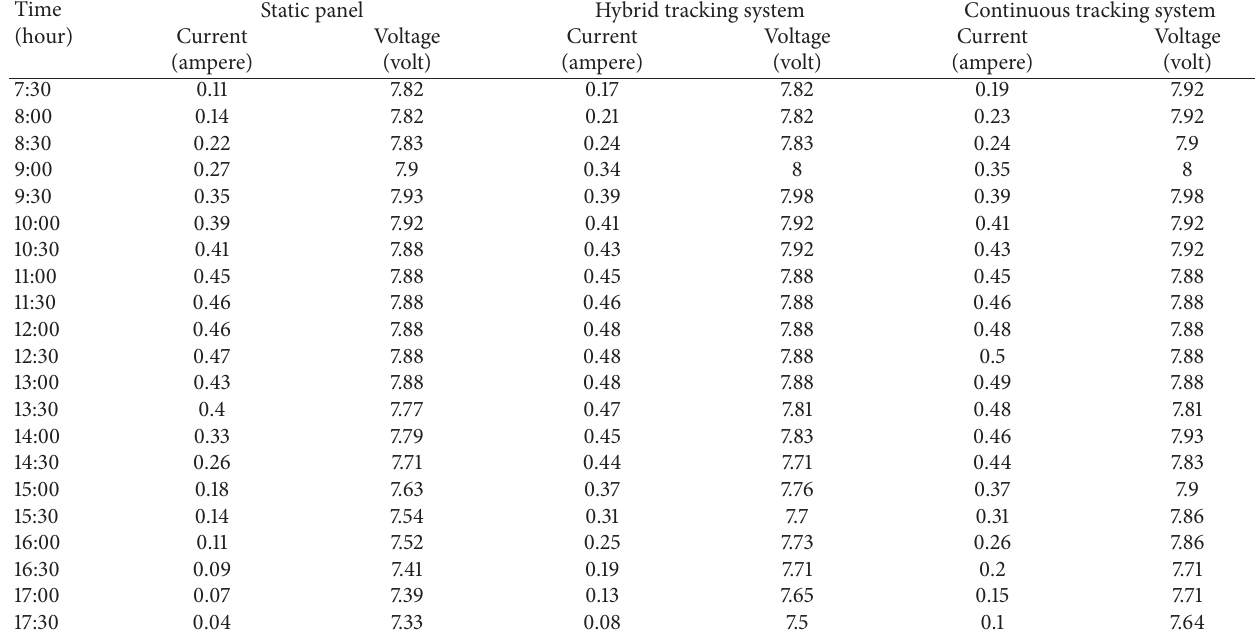
Table 2: Current and voltage values of static and tracking panel at different times in a day. Time